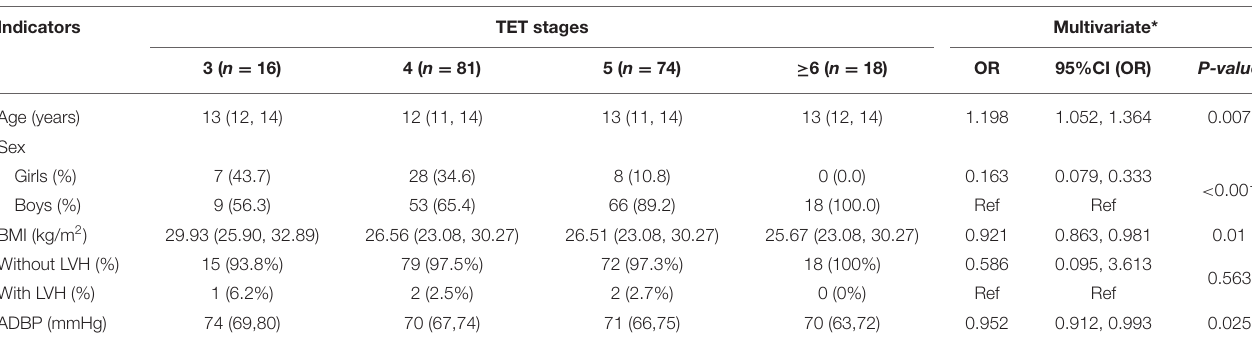
TABLE 5 | Multivariate analysis regarding TET stages in children with PHT.